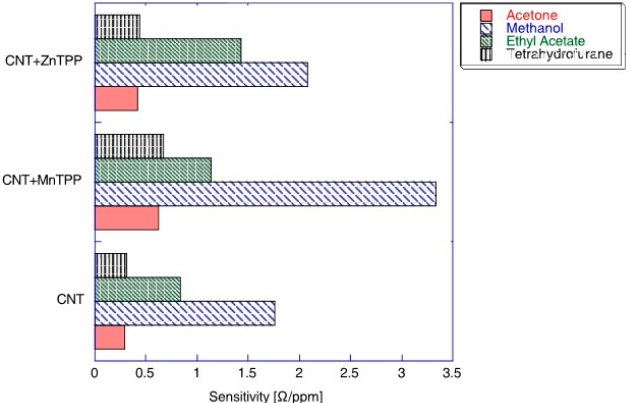
Figure 4. Sensitivity of the sensors composed of Mn-tetraphenylporphyrin-CNT, Zn- tetraphenylporphyrin-CNT hybrids, and CNT towards four vapors. The maximum sensitivity corresponds to the sensor sensitivity at low concentrations. Reprinted with the authors’ permission [25].